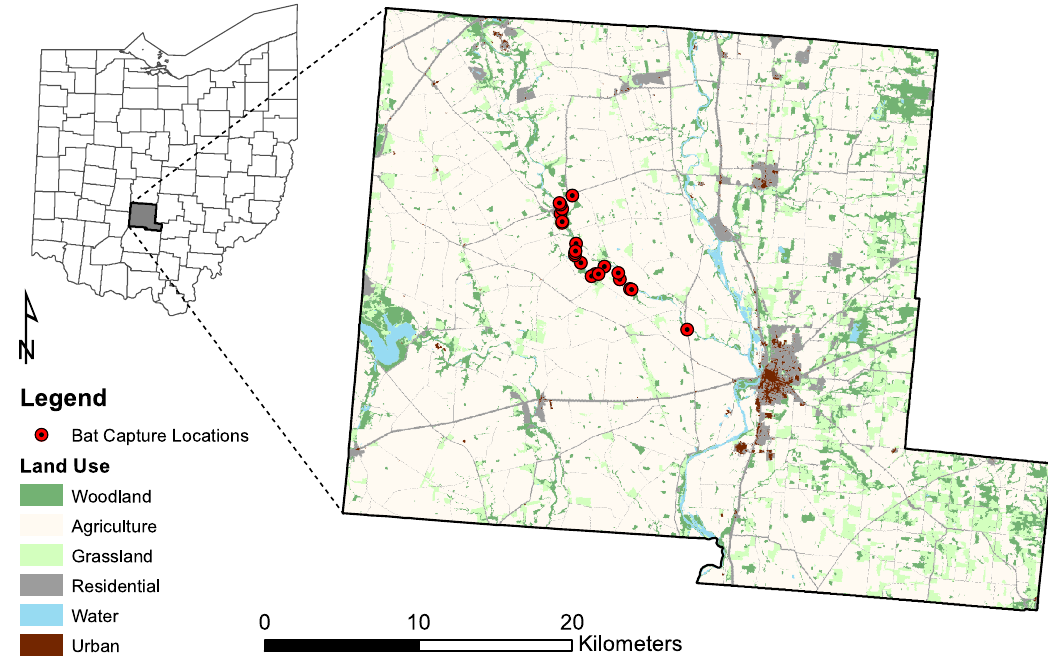
Figure 1. Indiana bat ( Myotissodalis ) capture locations and landscape configuration in Pickaway County, Ohio, USA.